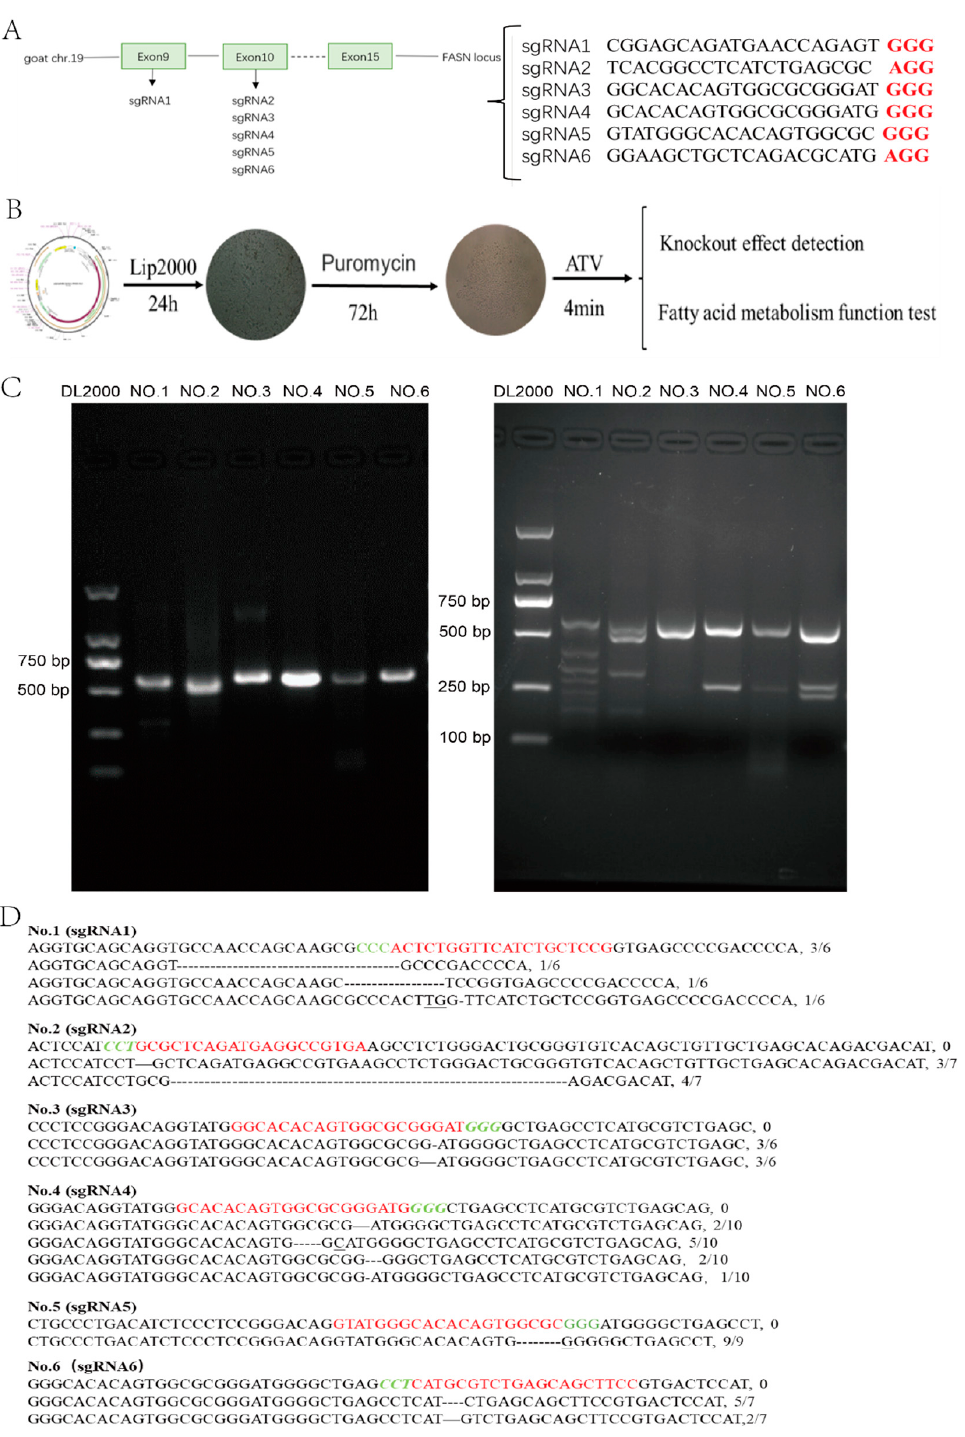
Figure 1. sgRNA design and screening. ( A ) Schematic illustration of the sites and sequence of sgRNA. Red is the PAM sequence. ( B ) Outline of the experimental protocol. Lip2000—transfection reagents; Puro—puromycin; ATV—cell dissociation solution. ( C ) Target fragment amplification and cutting efficiency. DL2000—DNA marker; NO.1—cells knockout by sgRNA 1; and others in the same way. NO.1 = 168 bp + 419 bp, NO.2 = 361 bp + 226 bp, NO.3 = 296 bp + 291 bp, NO.4 = 297 bp + 290 bp, NO.5 = 291bp + 296 bp, NO.6 = 328 bp + 259 bp. ( D ) Genotypes of sgRNA knockout. The first line was a wild-type sequence, with red indicating a sgRNA sequence and green indicating a PAM sequence, and the proportion of detected genotypes was displayed on the right side.